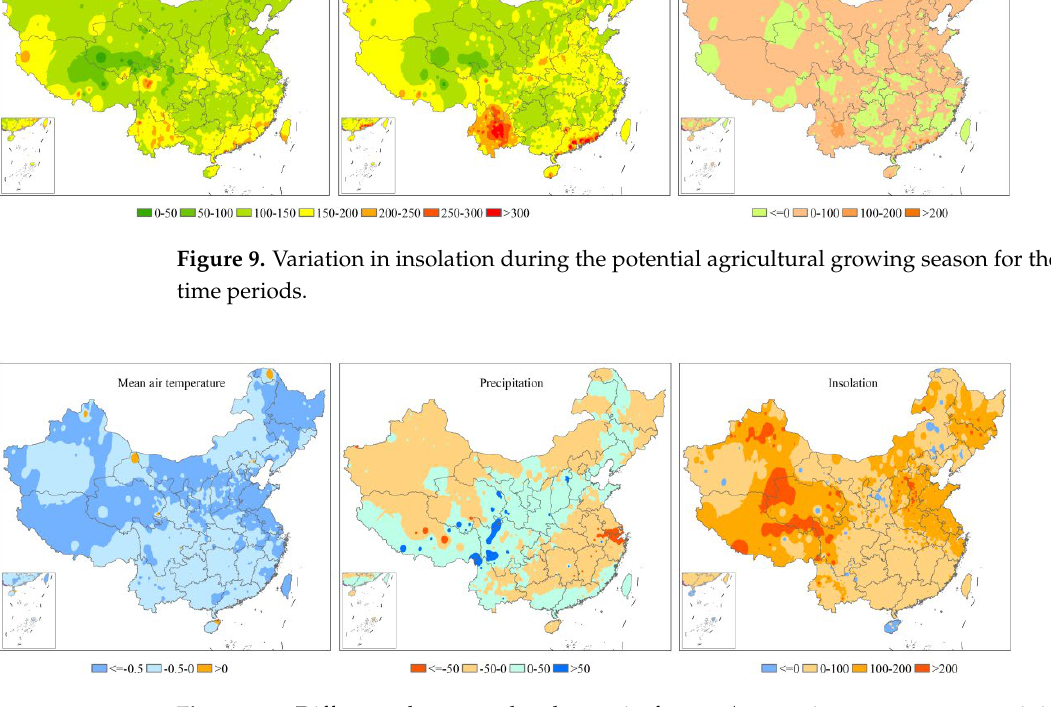
Figure 11. Difference between the variation of factors (mean air temperature, precipitation, and